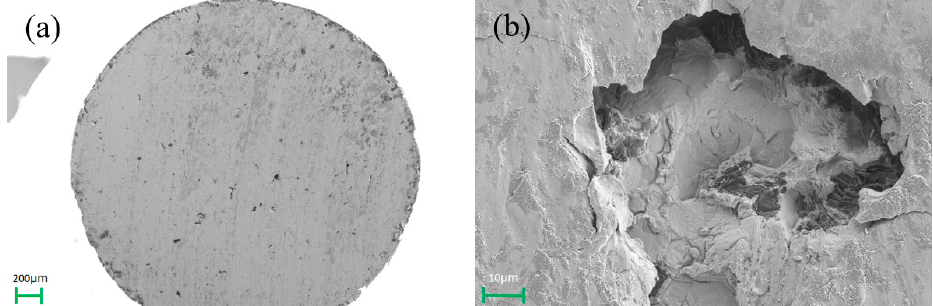
Figure 11. Overall surface morphology of vermicular cast iron after wear, captured at ( a ) low power and ( b ) high power.